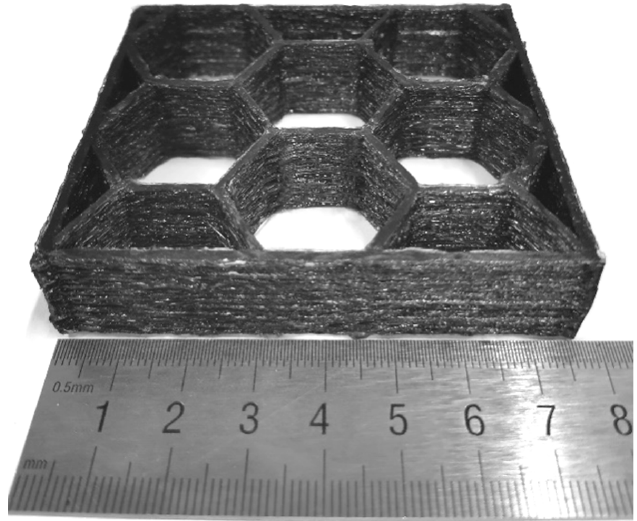
Figure 13. Additive manufacturing of continuous carbon fiber reinforced resin matrix composite cellular load-bearing structure.